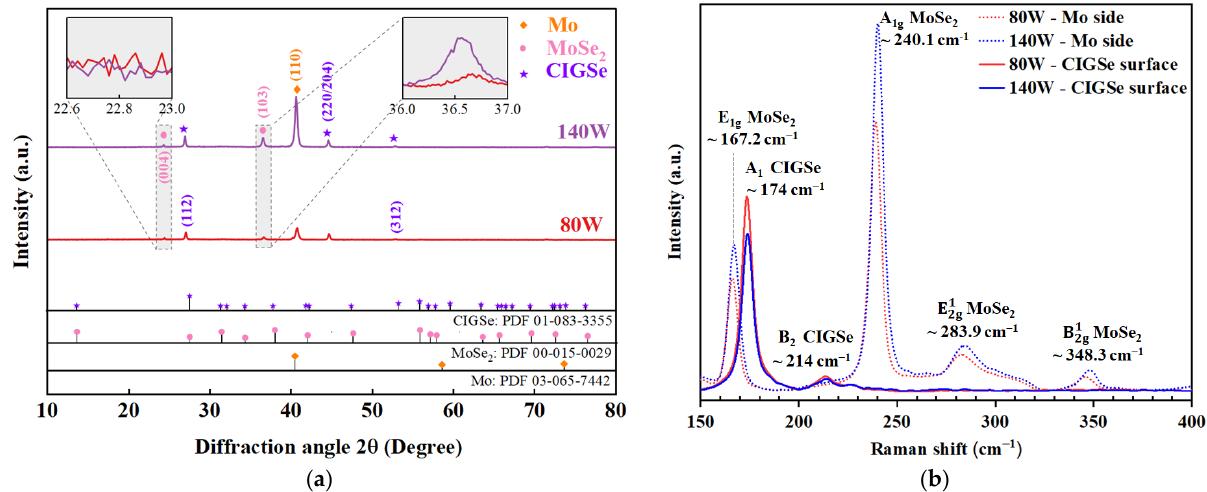
Figure 7. ( a ) 2D view of XRD patterns CIGSe/Mo samples grown at different powers with the presence of MoSe 2 phase at the CIGSe ‐ Mo interface ( b ) Comparison of Raman spectra from the Mo side (after lift ‐ off) and the CIGSe surface.